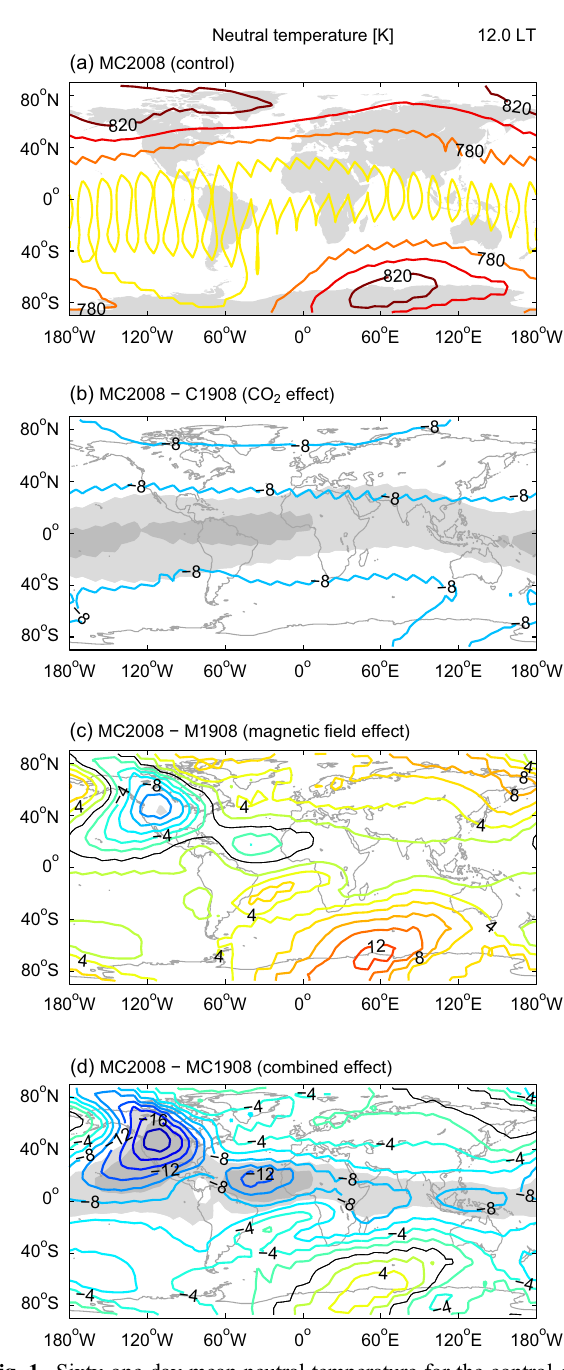
Fig. 1. Sixty-one-day mean neutral temperature for the control case (MC2008; panel a) and the difference with C1908, M1908, and MC1908 (panels b–d) at 12 LT at a pressure level of 3.2 · 10 (cid:2) 8 hPa (~300 km). The contour interval for the difference plots is 2 K between (cid:2) 12 and +12 K, with an additional contour at (cid:2) 16 K for the bottom panel. Light (dark) shading indicates statistical signifi- cance at the 95% (99%)